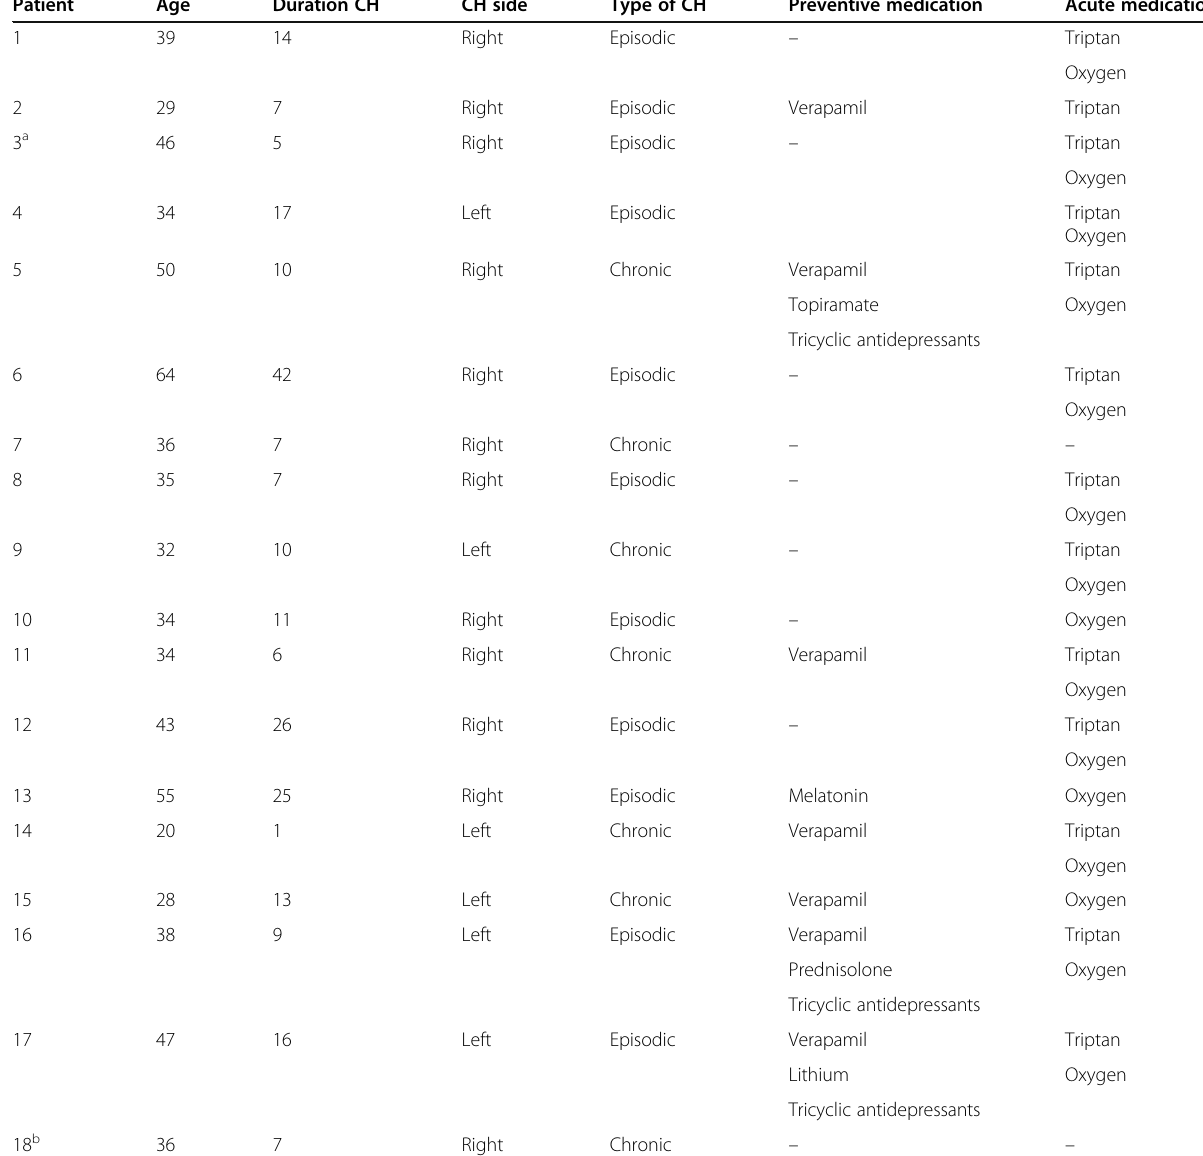
Table 1 Demographic and main clinical data from CH patients included in behavioural data analyses ( N = 17) Patient